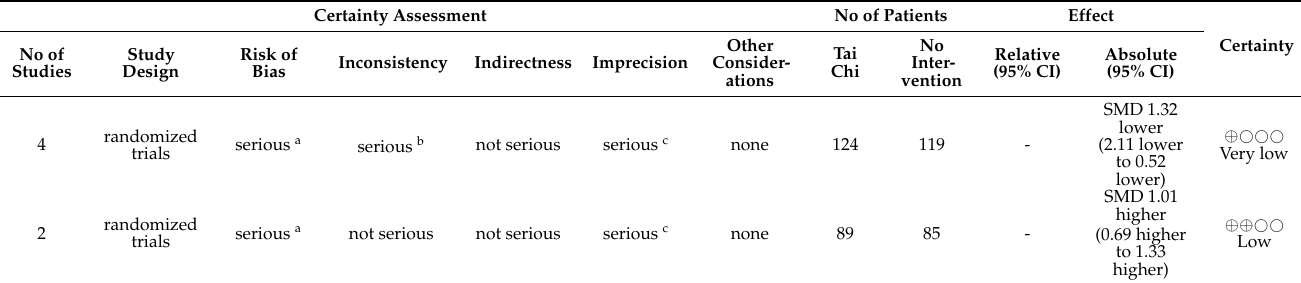
Figure 8. Forest plot shown for comparison of Tai Chi versus no intervention for depressive level outcome [46–48,51]. Note: Line indicates confidence interval and the green square indicates effect estimate. Black diamond indicates cumulative effect and its confidence interval. Table 3. Summary of the findings of the GRADE quality assessment for a comparison of Tai Chi versus no intervention.